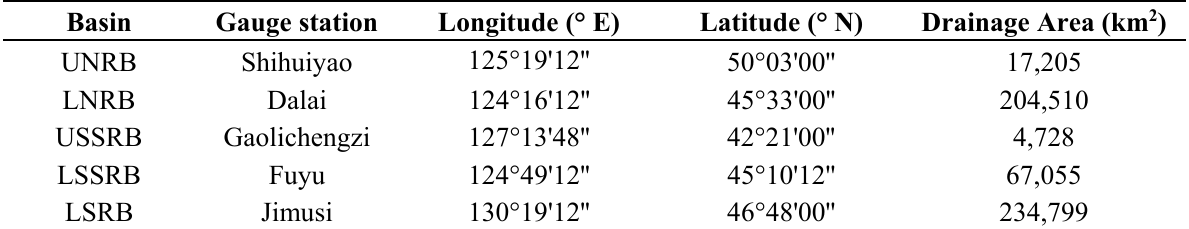
Table 1. Location, drainage area, and representative gauge stations of the Upper Nenjiang River Basin (UNRB), Lower Nenjiang River Basin (LNRB), Upper Second Songhua River Basin (USSRB), Lower Second Songhua River Basin (LSSRB), and Lower Songhua River Basin (LSRB) in Northeast